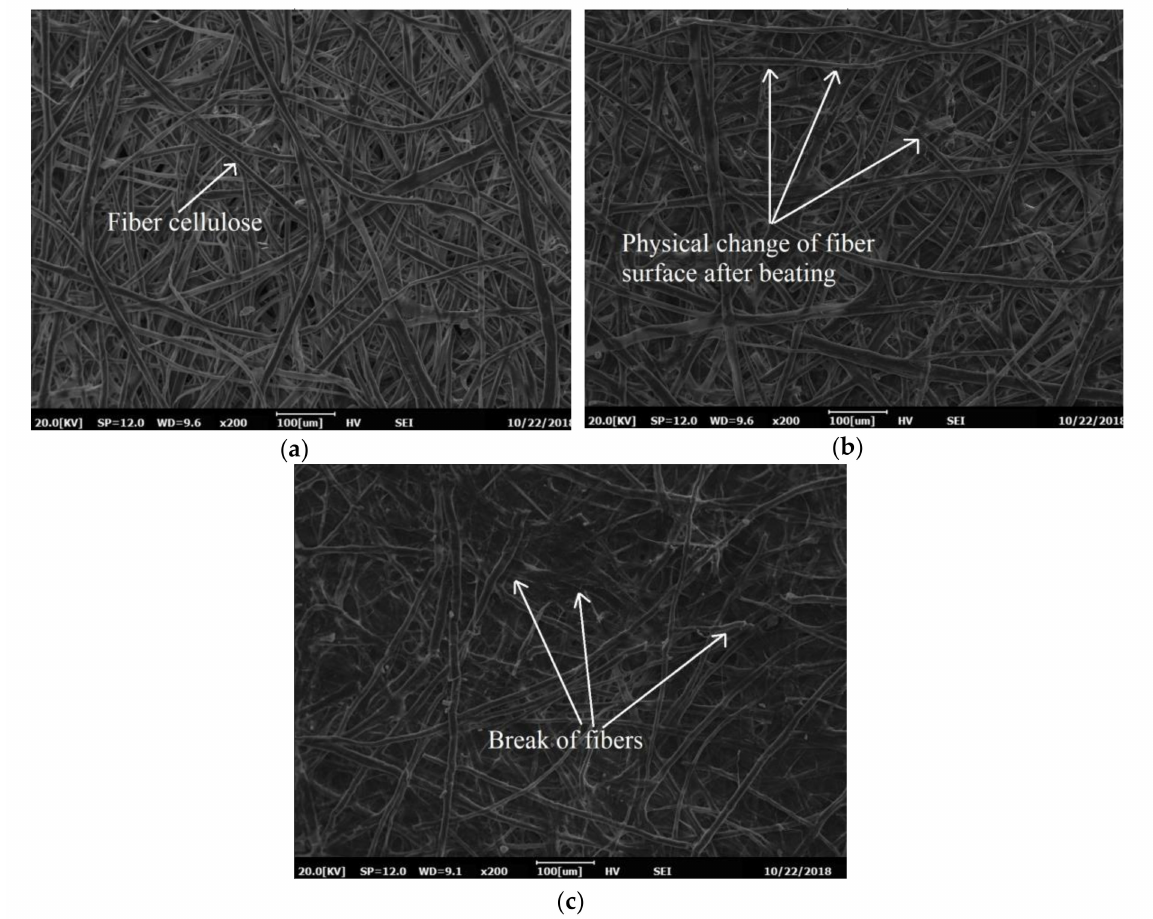
Figure 15. SEM images of Kenaf paper: ( a ) unbeaten pulp; ( b ) beaten at 6000 revolutions; and, ( c ) beaten at 12,000